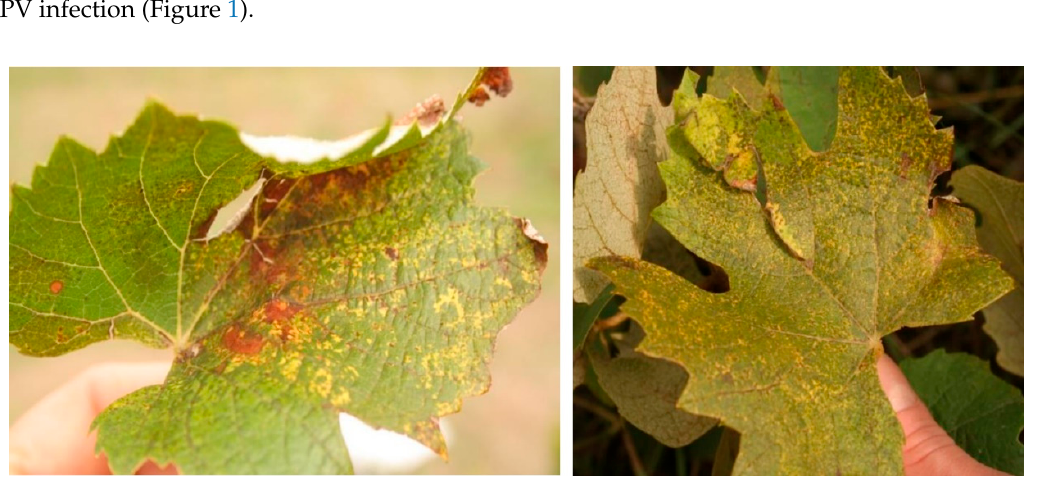
Figure 1. Symptoms of yellow ringspots on leaves of the Baco 22A rootstock in 2017.